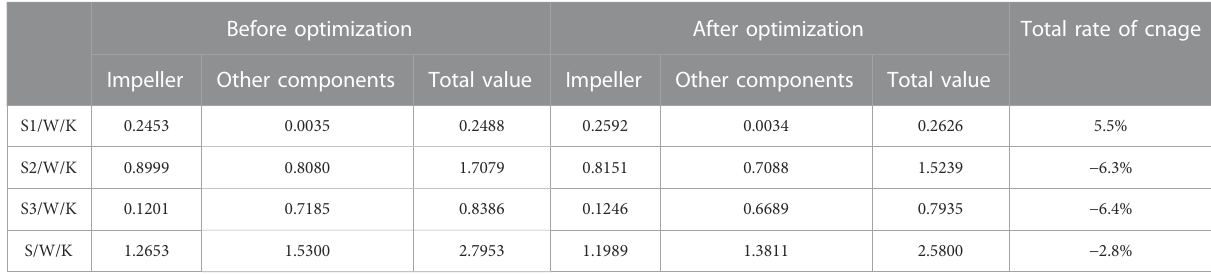
TABLE 3 Comparison of entropy generation value before and after optimization under rated working